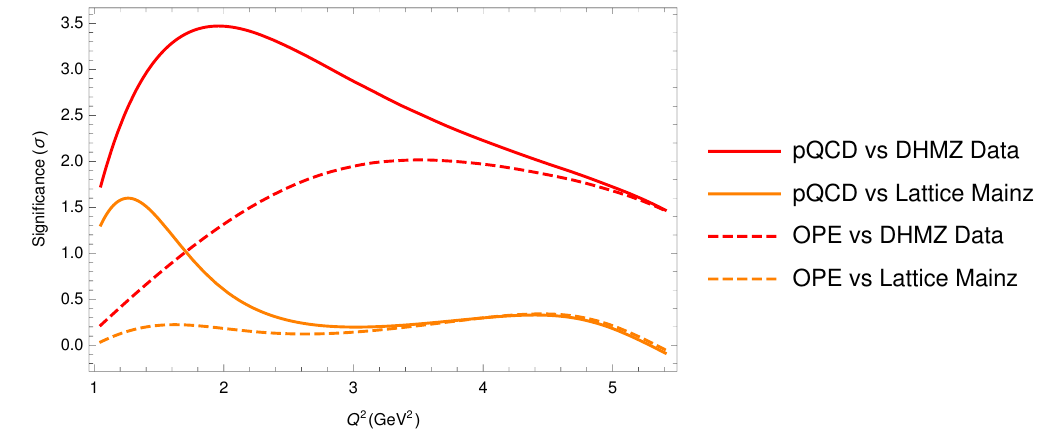
Figure 18 . Statistical significance of the difference between the Adler functions extracted from e + e − data and lattice results with respect to both the OPE and pQCD